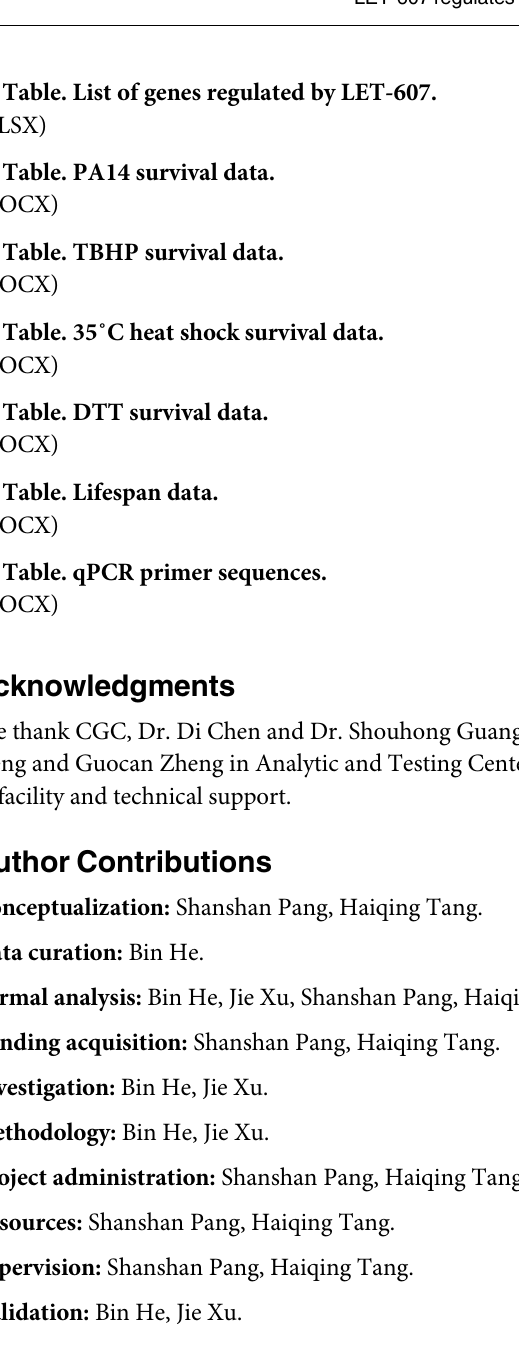
S1 Table. List of genes regulated by LET-607. S2 Table. PA14 survival data. S3 Table. TBHP survival data. S4 Table. 35˚C heat shock survival data. S5 Table. DTT survival data. S6 Table. Lifespan data. S7 Table. qPCR primer